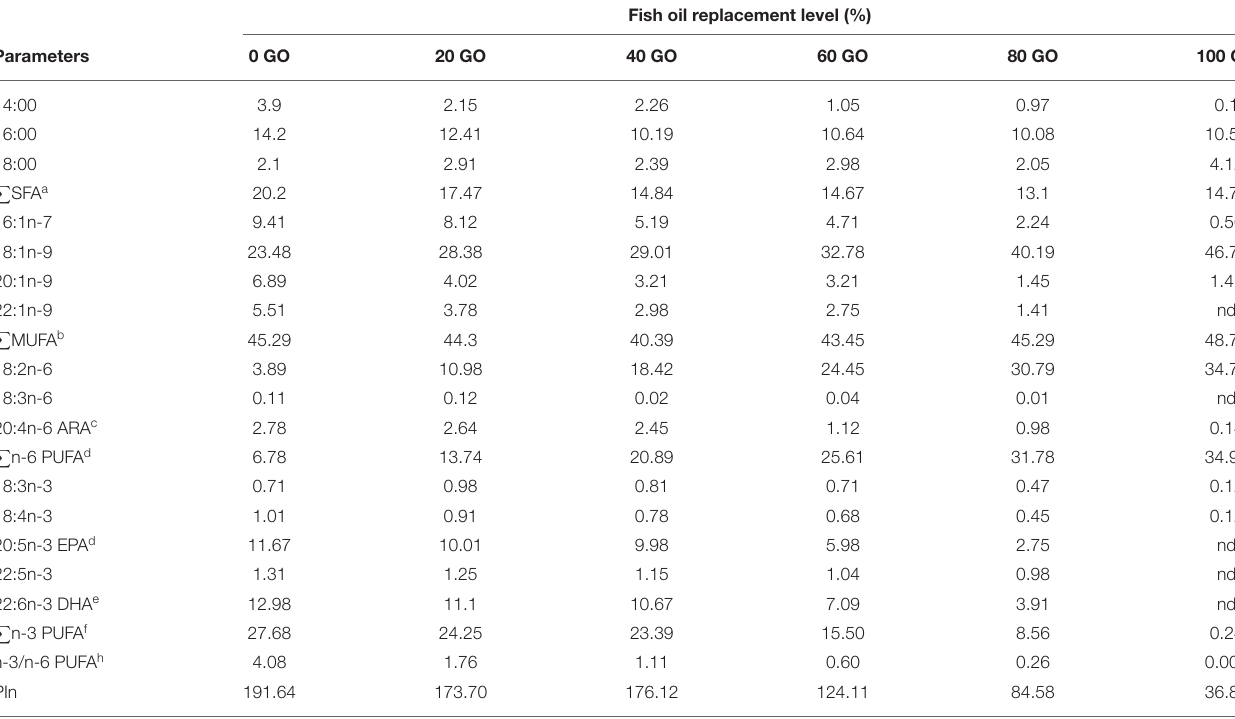
TABLE 2 | Fatty acid composition of experimental diets (% total fatty acids).